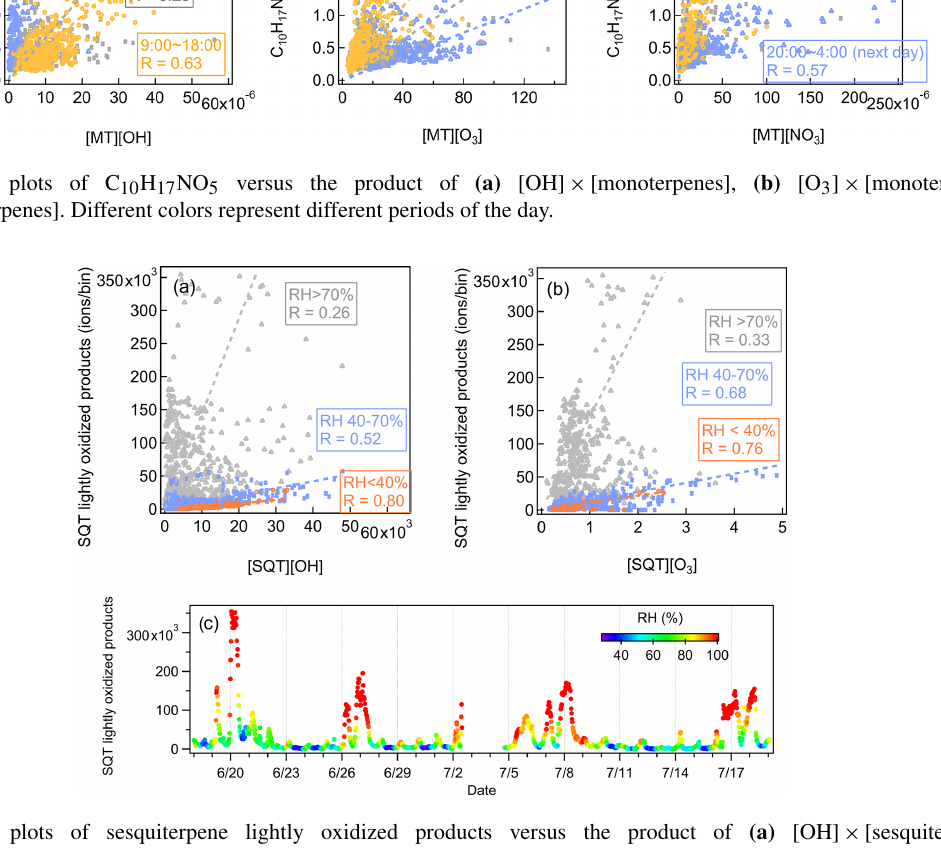
Figure 15. Scatter plots of sesquiterpene lightly oxidized products versus the product of (a) [OH] × [sesquiterpenes] and (b) [O 3 ] × [sesquiterpenes]. Different colors indicate different ranges of RH. (c) Time series of sesquiterpene lightly oxidized products colored by